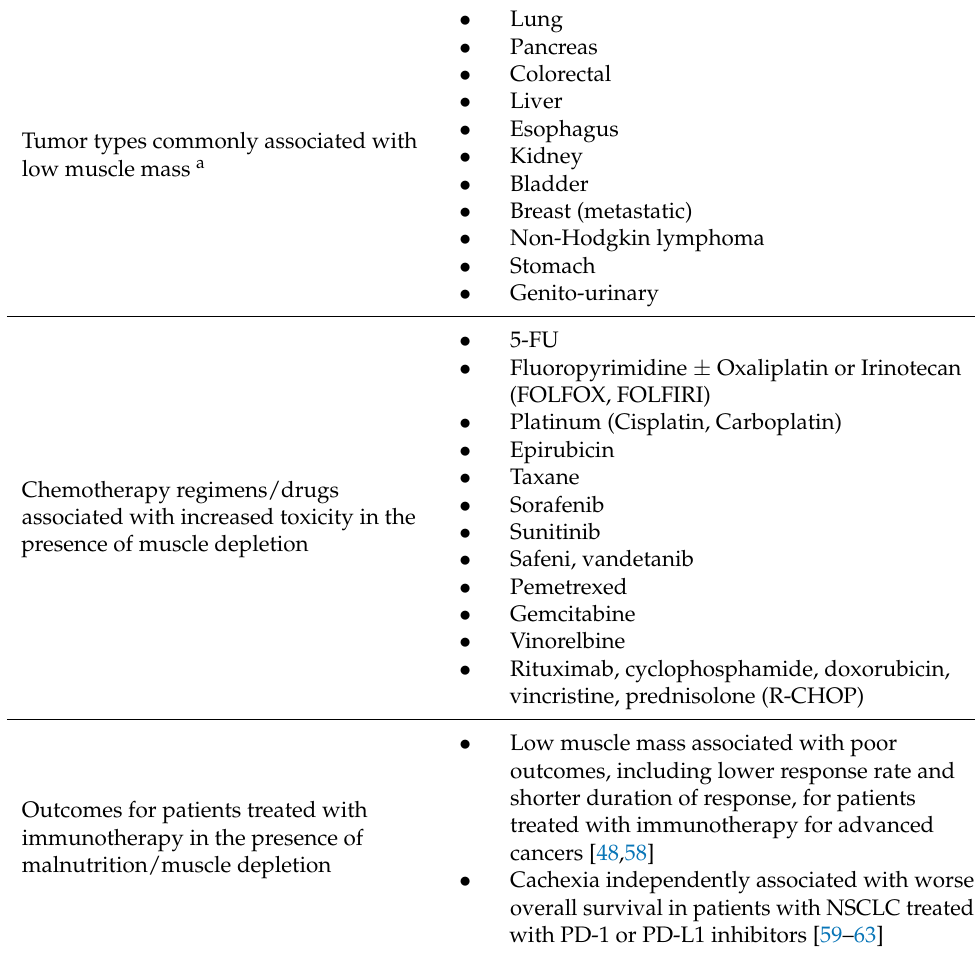
Table 1. Tumor types and/or treatments most closely associated with malnutrition and/or muscle depletion (adapted from Bozzetti 2017 [48])